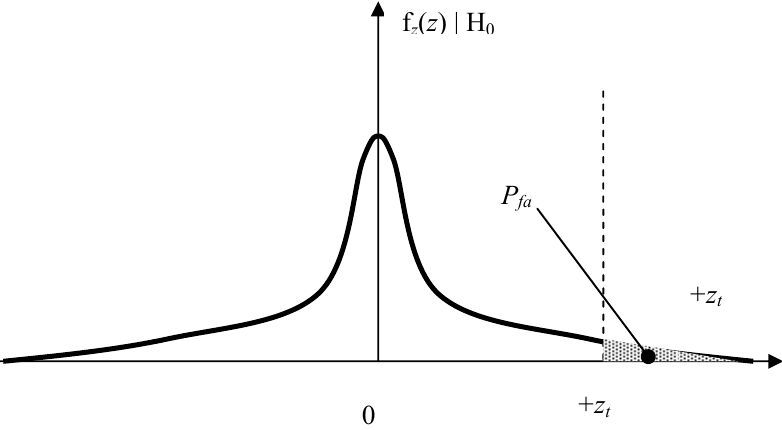
Figure 6. Probability of false alarm of a positive turnout detection D1|H0. The threshold . value in deg/sec is z t